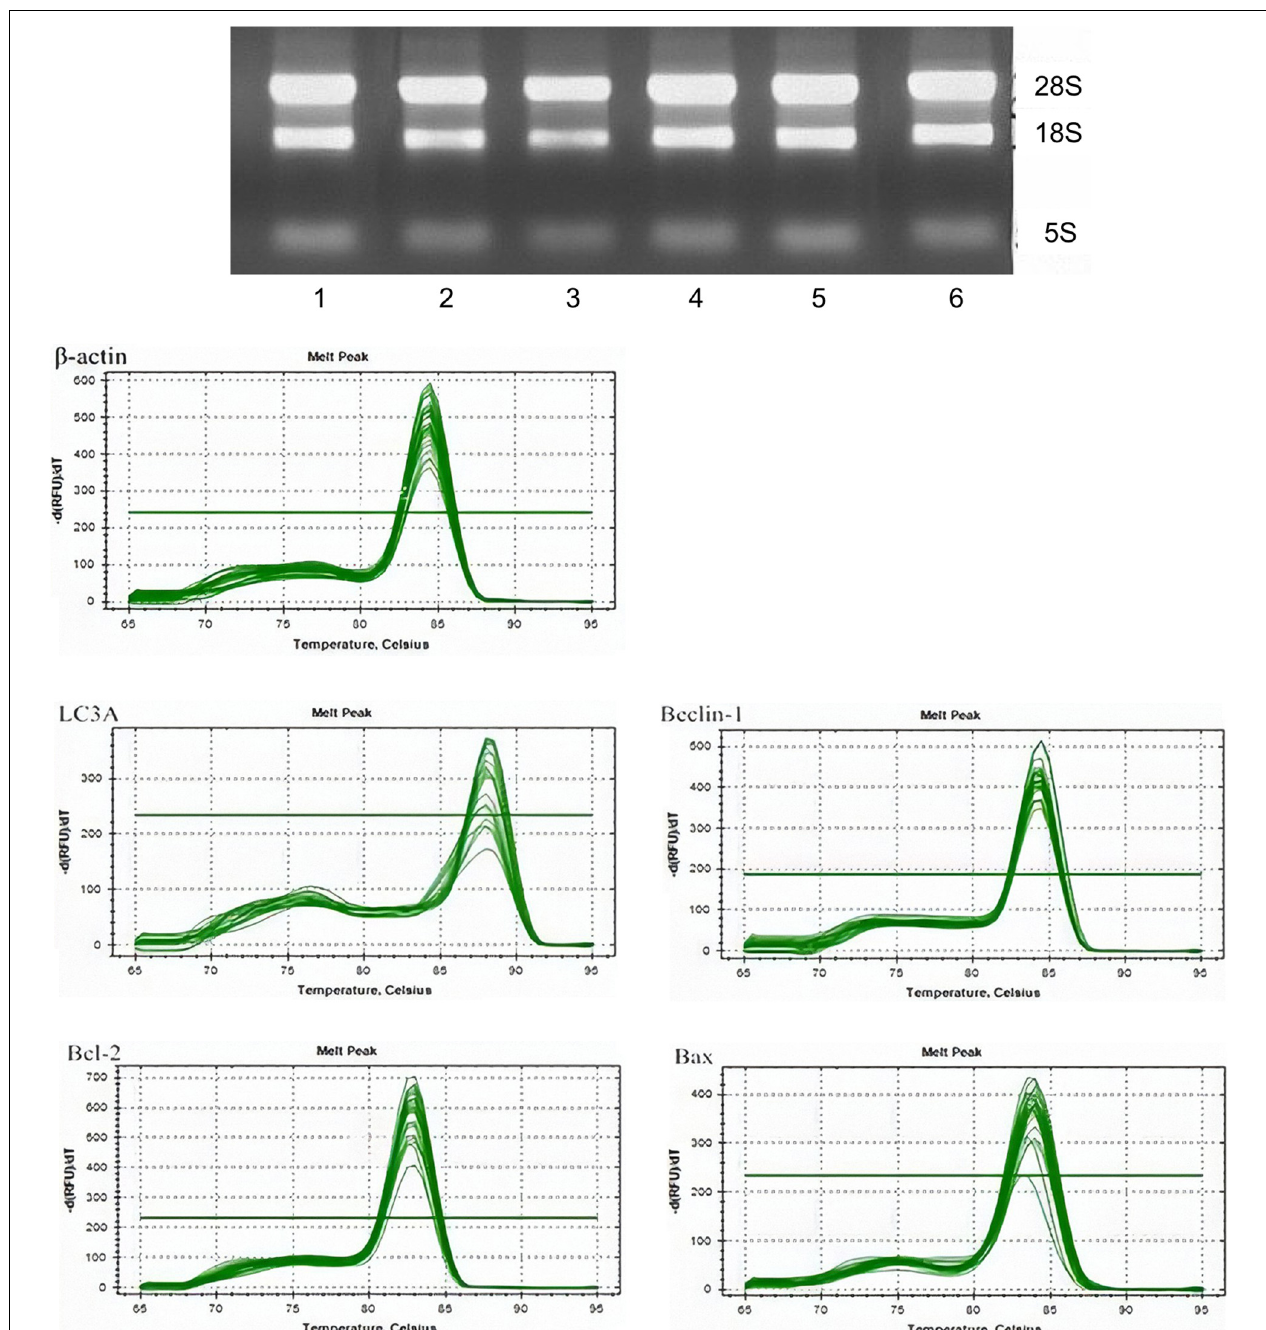
FIGURE 2 | The messenger RNA (mRNA) expressions of LC3A, Beclin 1, Bcl-2, and BAX in osteoblasts. The mRNA expressions of LC3A, Beclin 1, Bcl-2, and BAX in the following groups of osteoblasts were assessed by real-time quantitative polymerase chain reaction: control group; low-fluoride (2.5 mg/L) group; high-fluoride (5 mg/L) group; control + 3-MA (10 mmol/L) group; low-fluoride (2.5 mg/L) + 3-MA (10 mmol/L) group; high-fluoride (5 mg/L) + 3-MA (10 mmol/L) group. * indicates P < 0.05 compared with the control group; # indicates P < 0.05 compared with the low fluoride group; & indicates P < 0.05 compared with the high fluoride